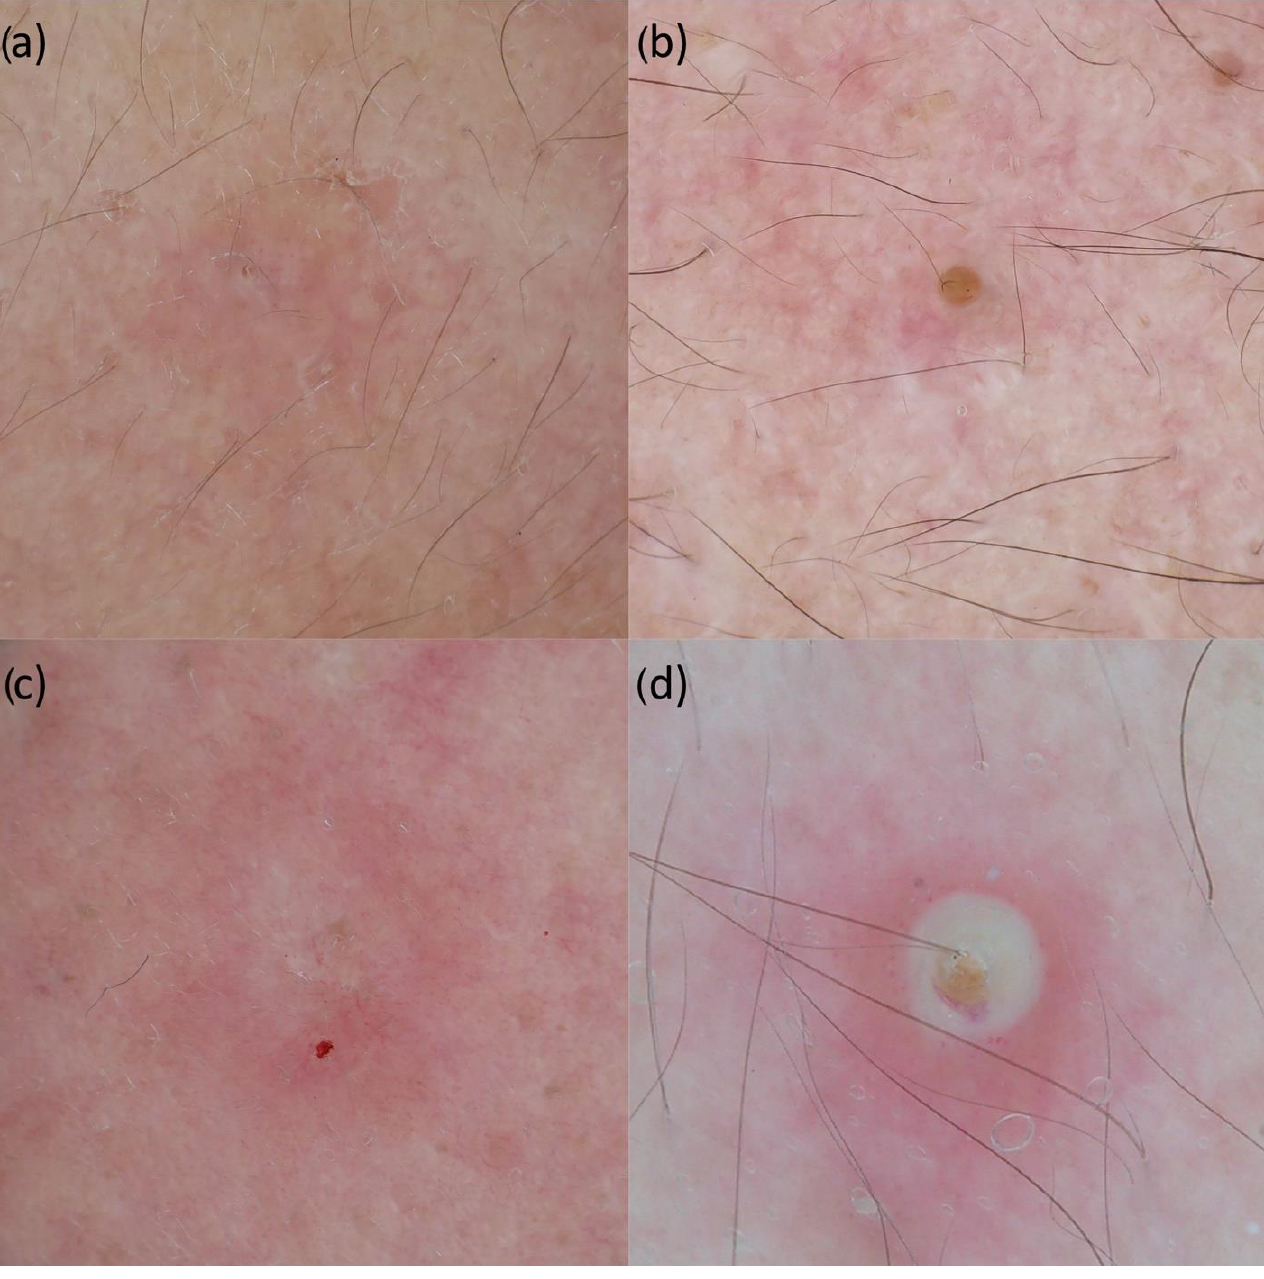
Figure 2. Dermoscopic images of closed comedo ( a ), open comedo ( b ), papule ( c ), and pustule ( d ).